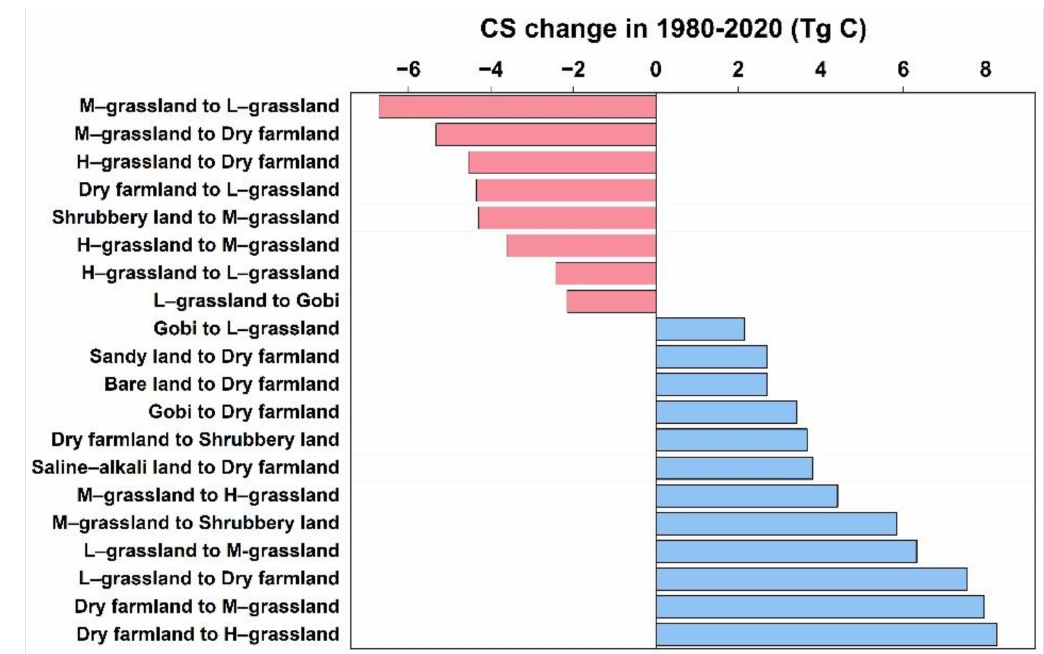
Figure 5. ( a – c ): The spatial distribution of CS across Gansu in 1980–2020; ( d ): The relative rates of CS change in 1980–2020. Note: Carbon storage per pixel (300 m × 300 m).